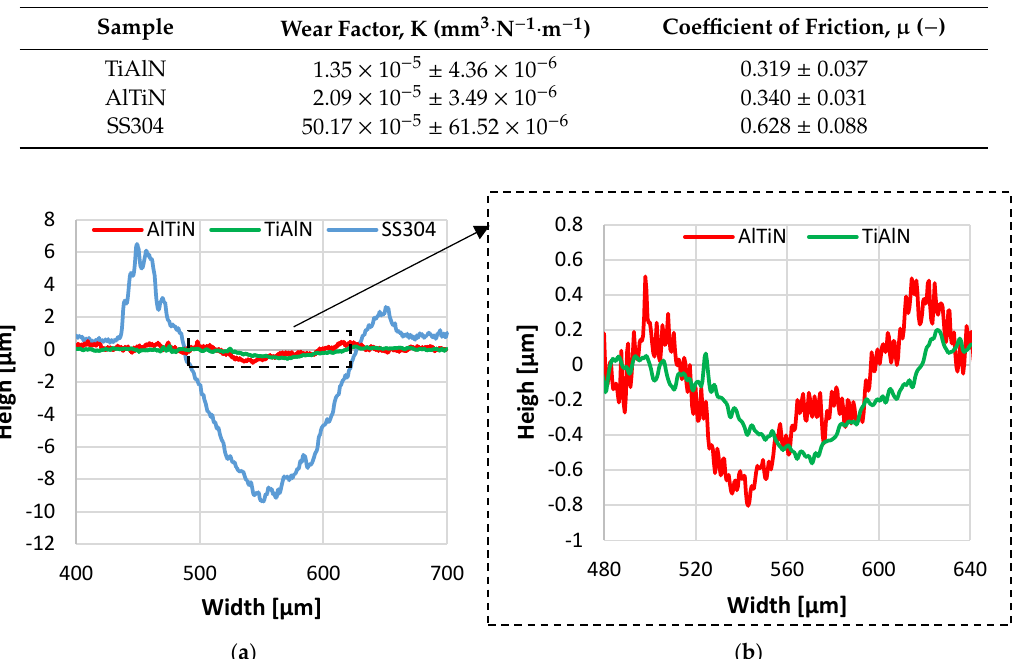
Figure 10. Sliding wear profiles: ( a ) films and stainless steel sample; ( b ) enlarged selected area of the TiAlN and AlTiN wear traces from ( a ).